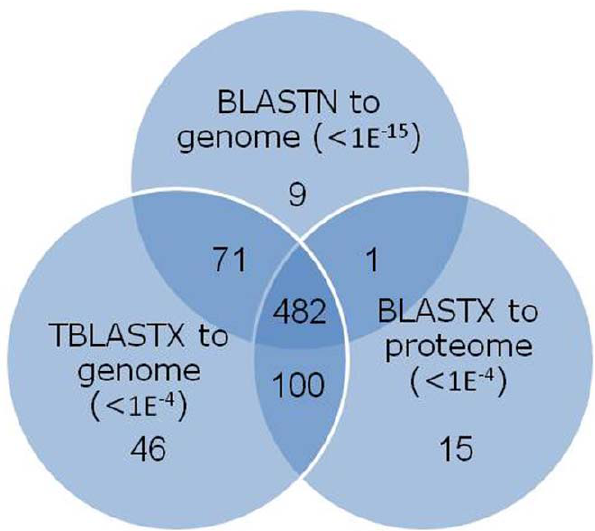
Figure 2. Venn diagram indicating the number of assembled An.funestus ESTs that showed significant similarity to the An. gambiae genome or proteome by one or more BLAST tools.